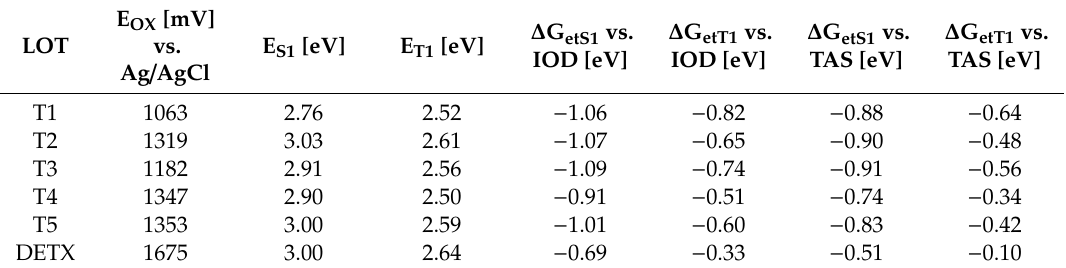
E S1 —singlet state energy of sensitizer determined based on absorption and emission. E T1 —triplet state energy calculated from molecular orbital calculations (uB3LYP/6-31G* level of theory). Δ G et calculated from the equation: ΔG (cid:2915)(cid:2930) = F(cid:4674)E (cid:2925)(cid:2934) (cid:4672) (cid:2888)